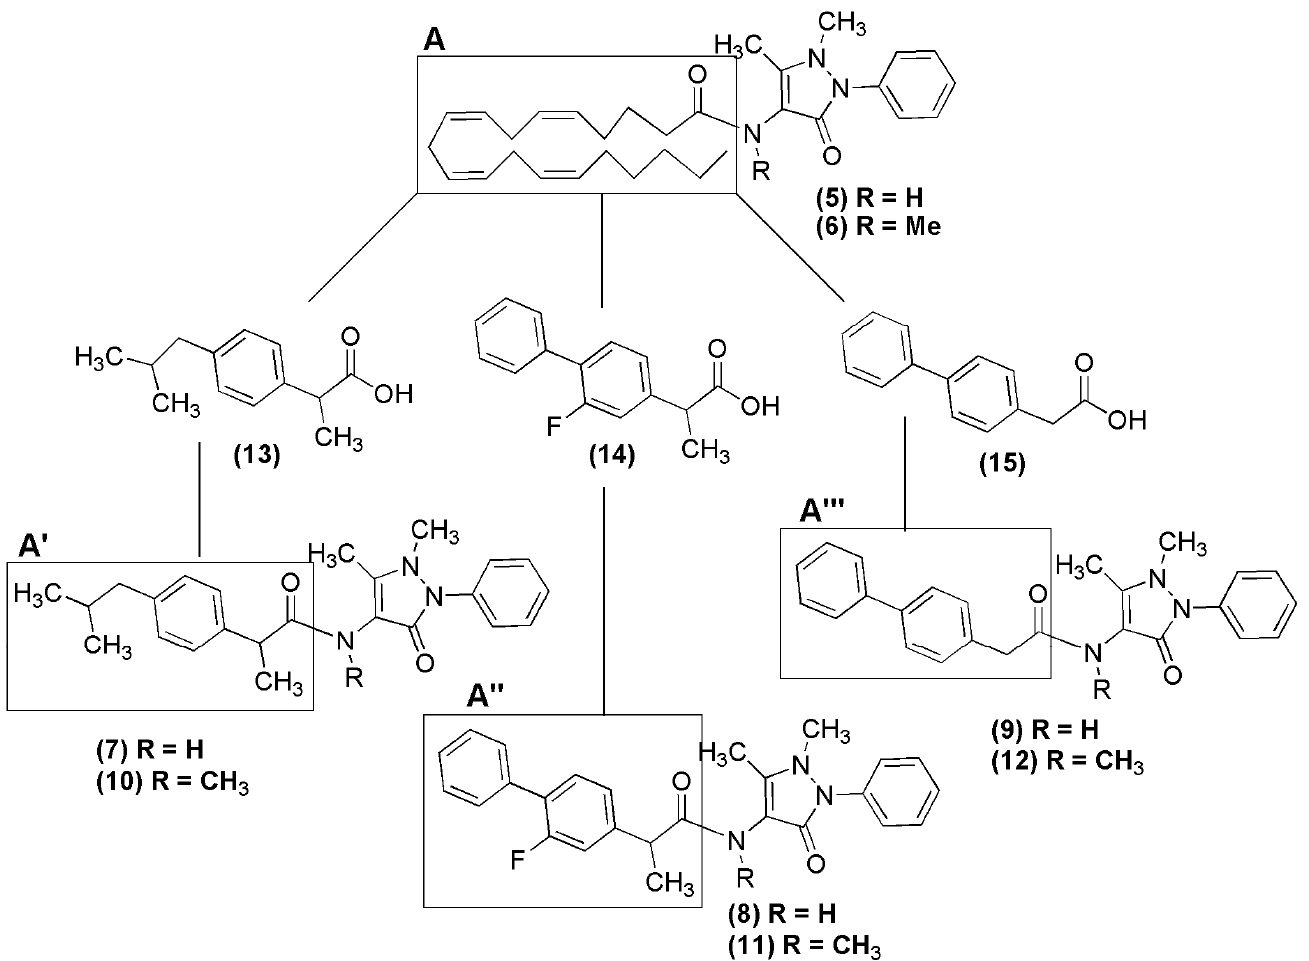
Figure 2. Design concept of novel NSAID-pyrazolamide derivatives ( 7 – 12 ).